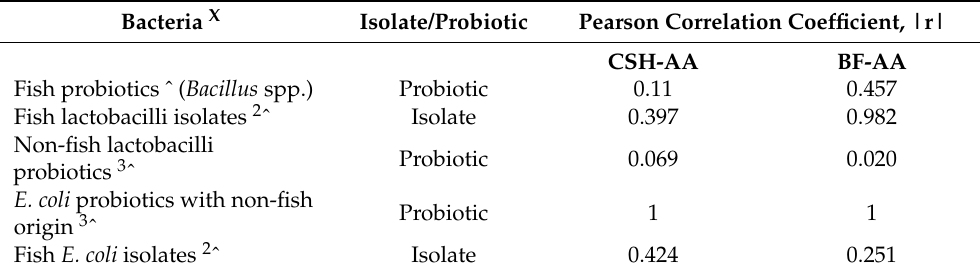
Table 5. Correlations: cell surface hydrophobicity and auto-aggregation ability, biofilm formation and auto-aggregation